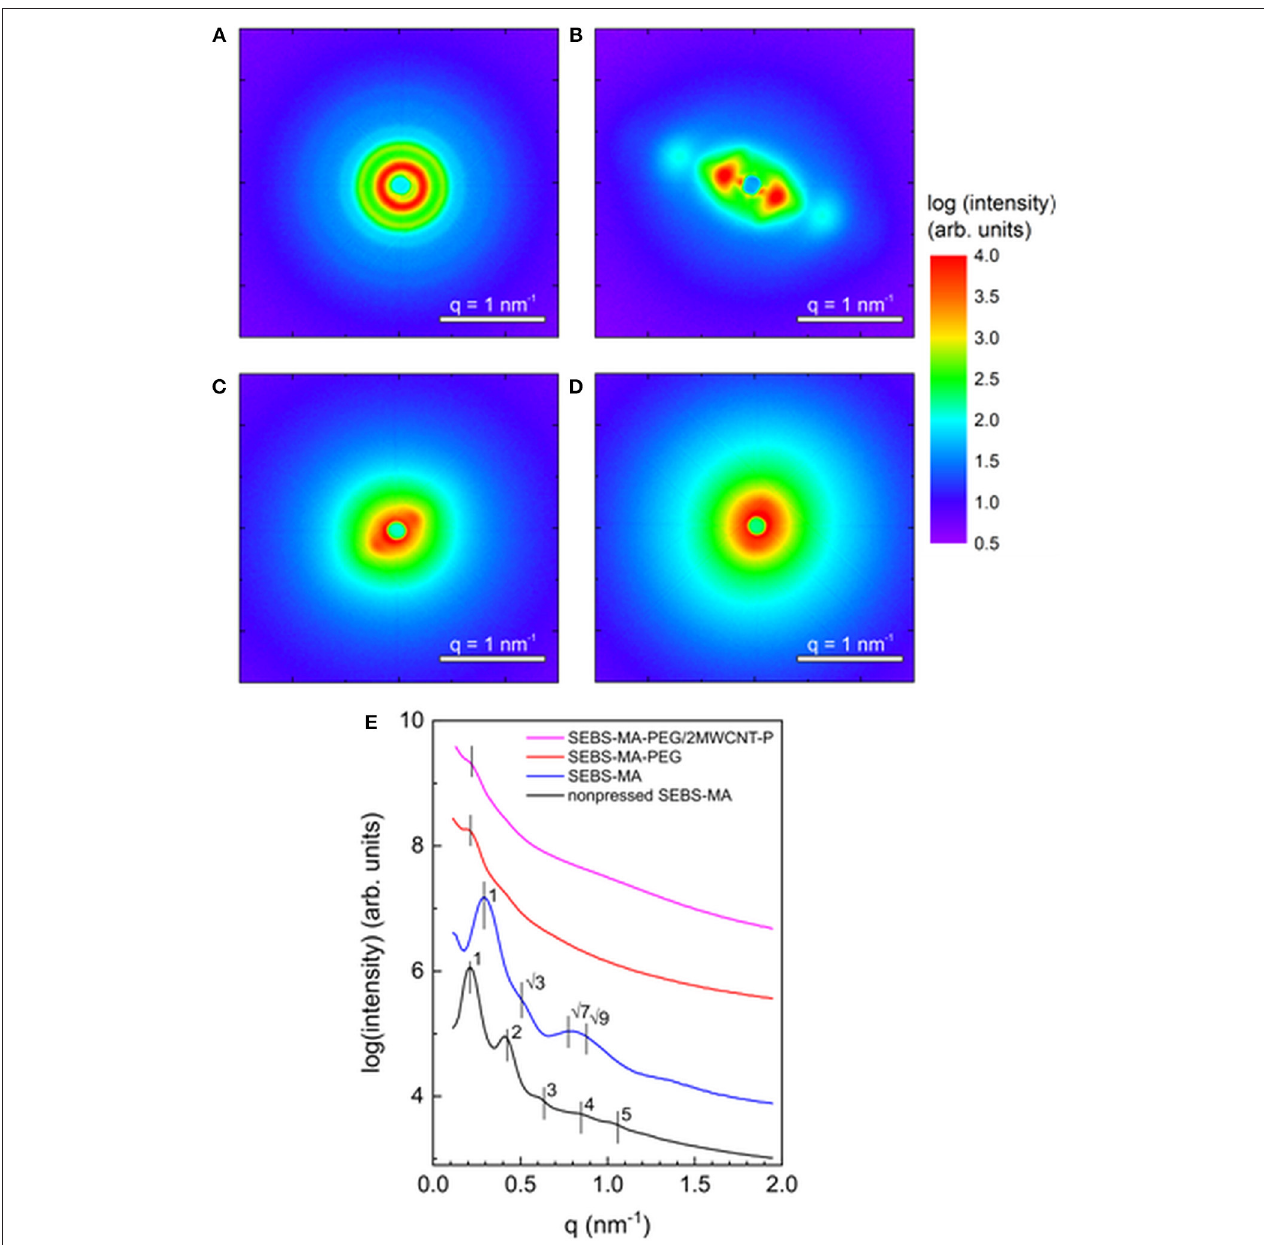
FIGURE 4 | SAXS patterns of (A) nonpressed SEBS-MA, and pressed (B) SEBS-MA, (C) SEBS-MA-PEG, and (D) SEBS-MA-PEG/2MWCNT-P. (E) Extracted SAXS intensity profiles. The vertical lines denote the maxima positions of Bragg